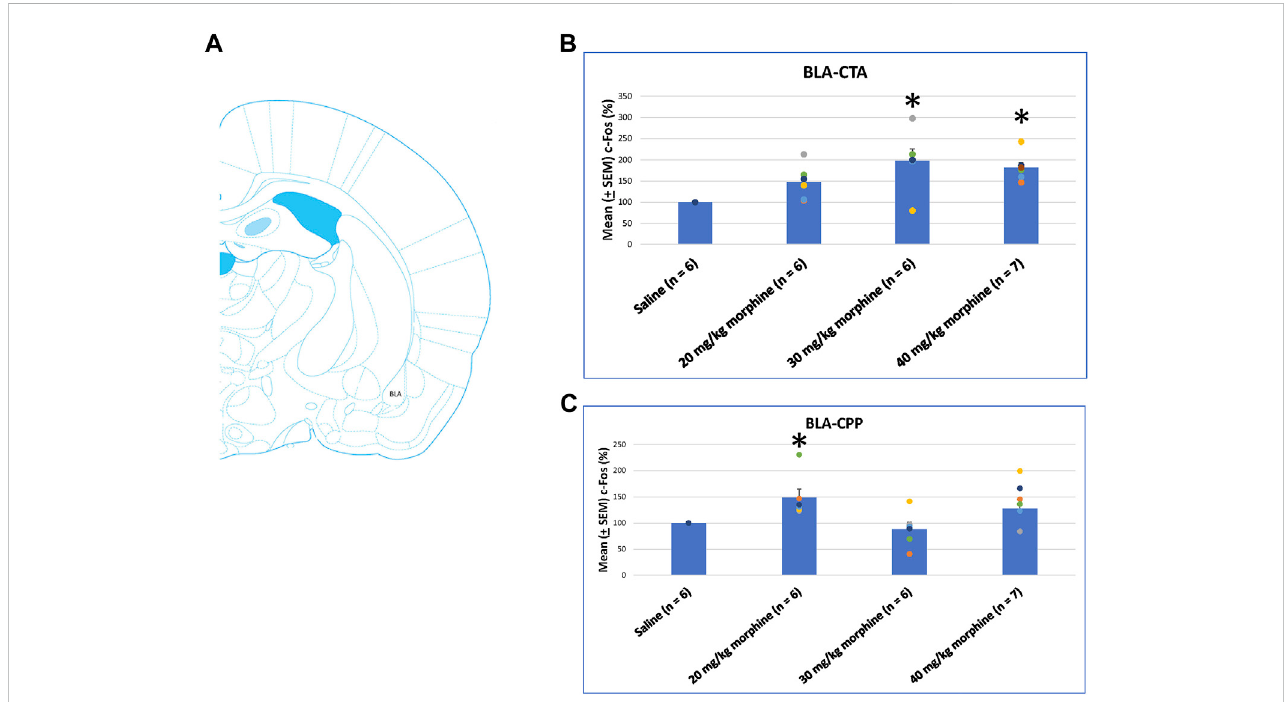
FIGURE 11 (A) Representative imageofc-Fosimmunoreactivityinthebasolateralamygdala (BLA).Mean(±SEM) c-Fos(%)intheBLA inthefollowing (B) CTAand (C) CPPtests.* p < 0.05whencomparingthesalineforCTAandCPP(both, n =6)orwithmorphineindosesof20 mg/kgforCTAandCPP(both, n =6),30 mg/kg for CTA and CPP (both, n = 6), and 40 mg/kg for CTA ( n = 6) and CPP ( n =